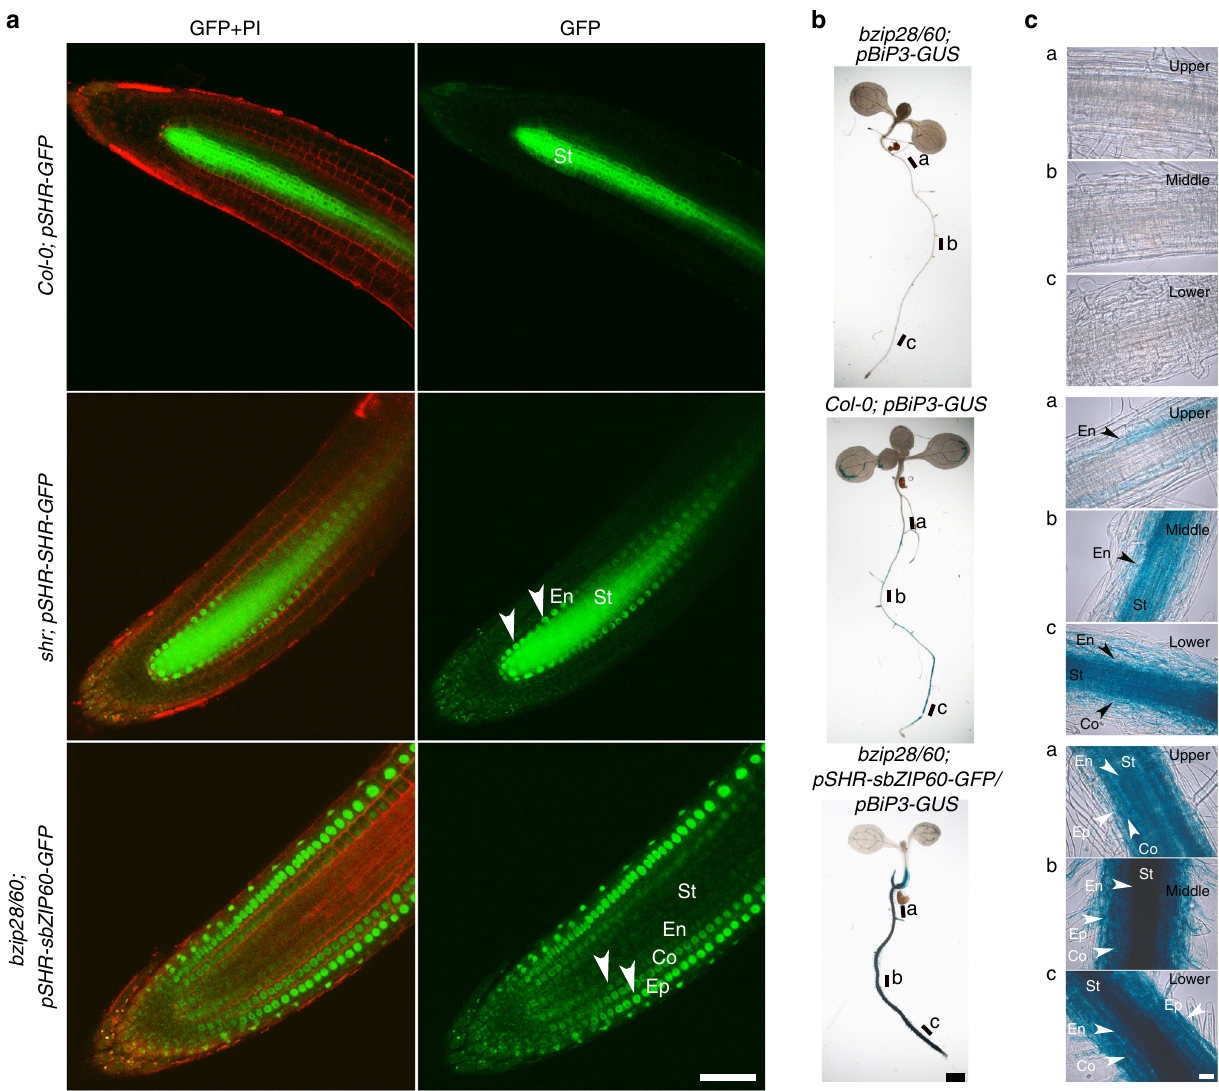
Fig. 1 Intercellular translocation of sbZIP60 induces BiP3 expression in systemic tissues. a Confocal laser scanning microscopy of Col-0; pSHR-GFP , shr ; pSHR-SHR-GFP , and bzip28/60 ; pSHR-sbZIP60-GFP at the primary root tips of 5-day-old transgenics reveals stele (St) accumulation of GFP, and stele and endodermis (En) distribution of SHR-GFP; noticeably, sbZIP60-GFP is localized in the stele, endodermis, cortex (Co) and epidermis (Ep). Similarly to SHR- GFP, sbZIP60-GFP is localized in nuclei (arrows). As also reported earlier 22 , we did not fi nd SHR-GFP localization in the nuclei of the cortex and epidermis. Propidium iodide (PI) was used for counterstaining. Scale bar: 50 μ m. b Expression of pBIP3:GUS in bzip28/60 , Col-0 and